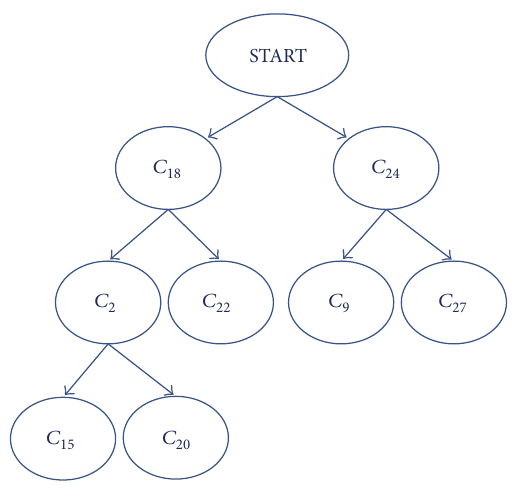
Figure 10: Structure of intended routes.